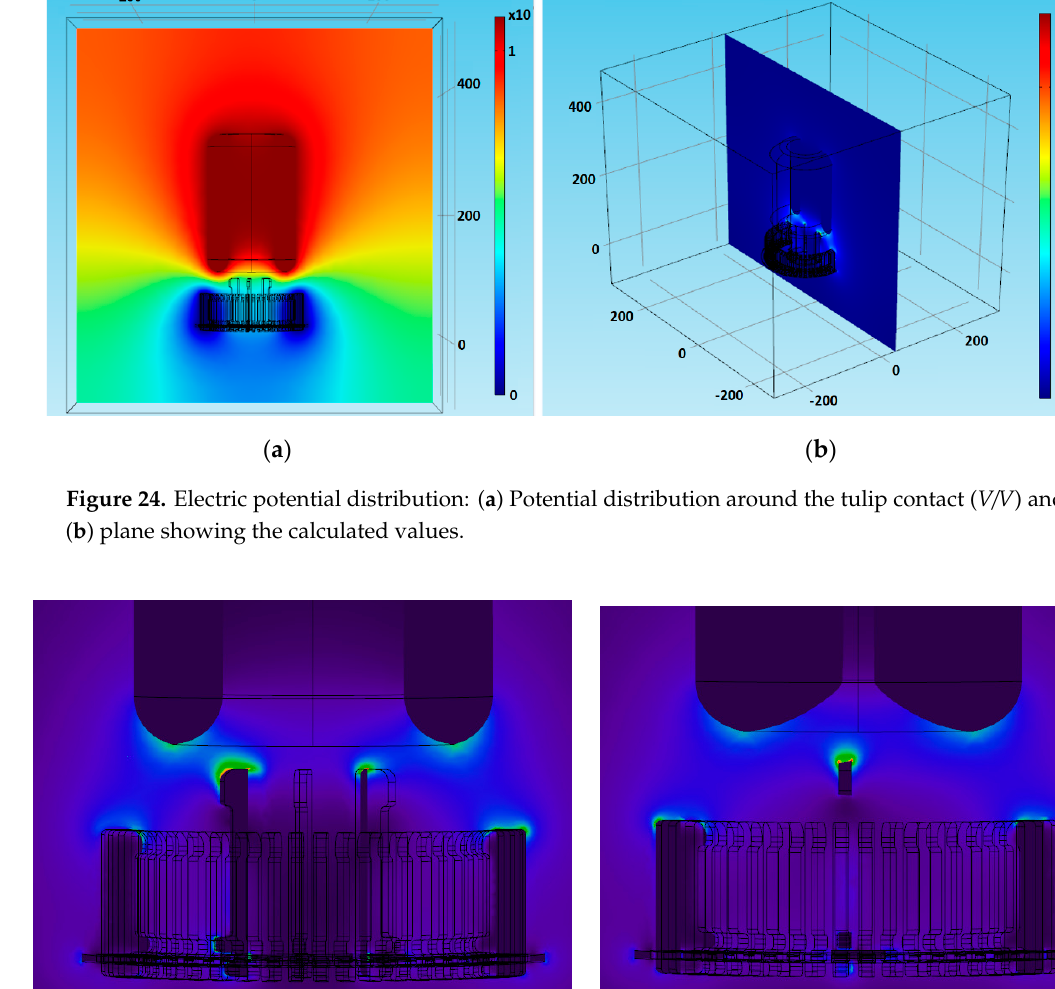
Figure 24. Electric potential distribution: ( a ) Potential distribution around the tulip contact ( V/V ) and ( b ) plane showing the calculated values.